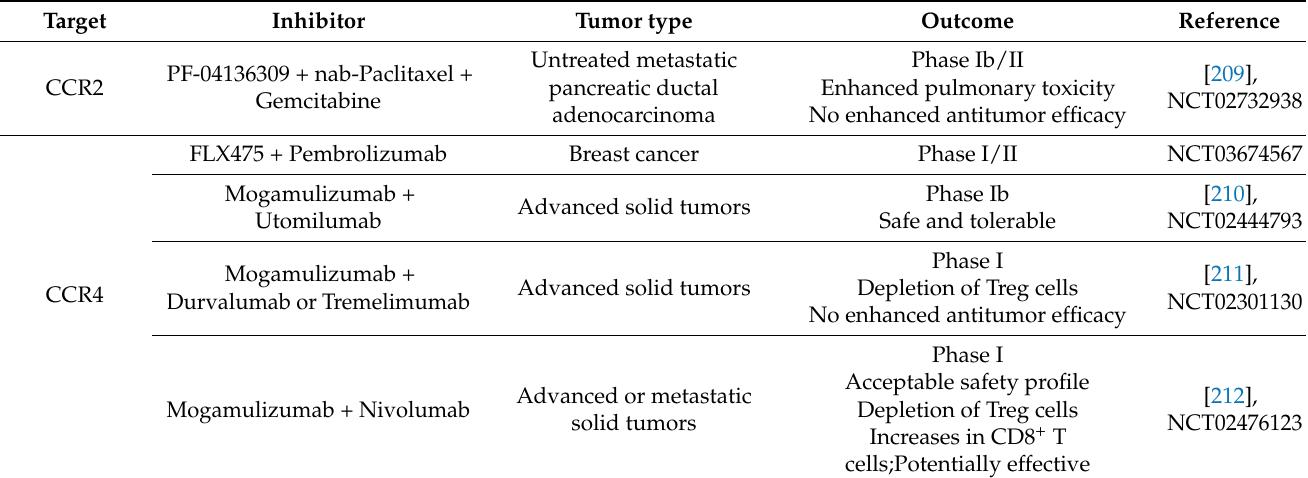
Table 3. Therapeutic effects of chemokine receptor inhibitors in clinical